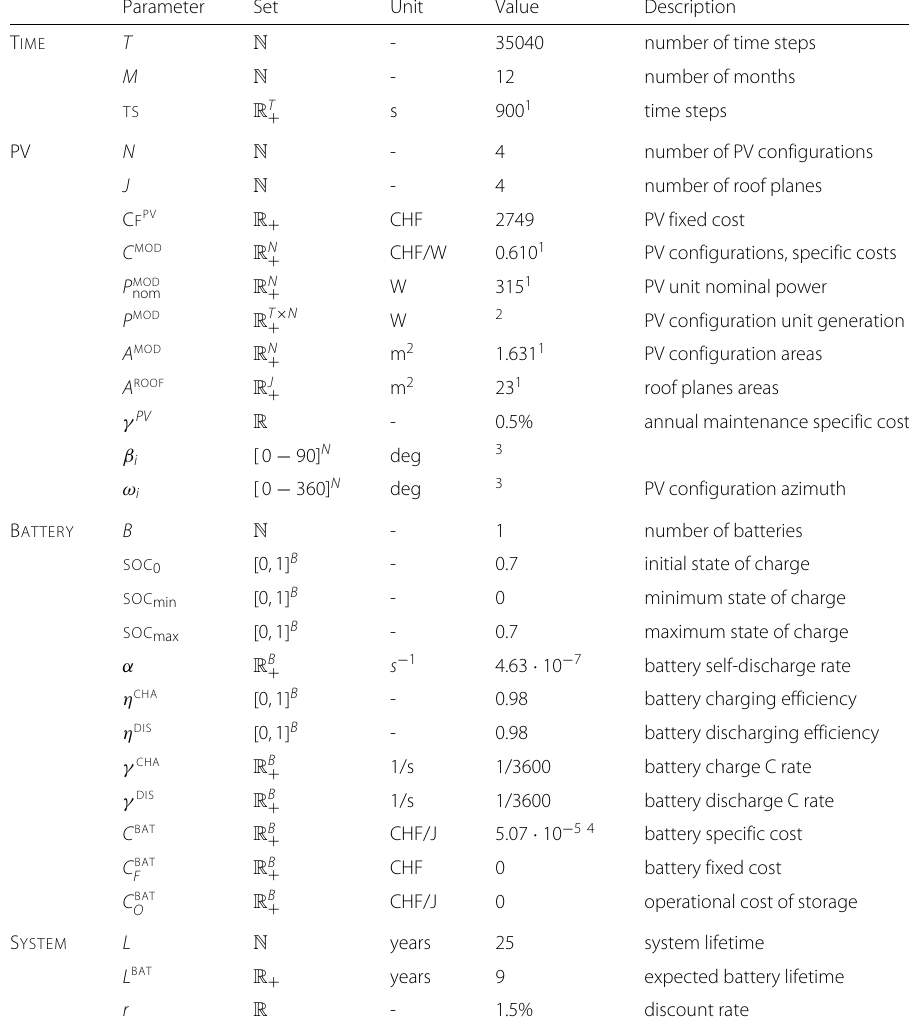
Table 5 Parameters